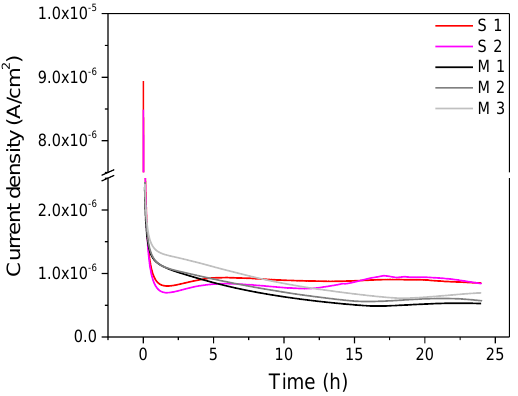
Figure 7. Current transients during potentiostatic passivation at 0.5 V SCE for 24 h. The passive current density reached 8.4 × 10 − 7 –8.5 × 10 − 7 A/cm 2 for the S specimens